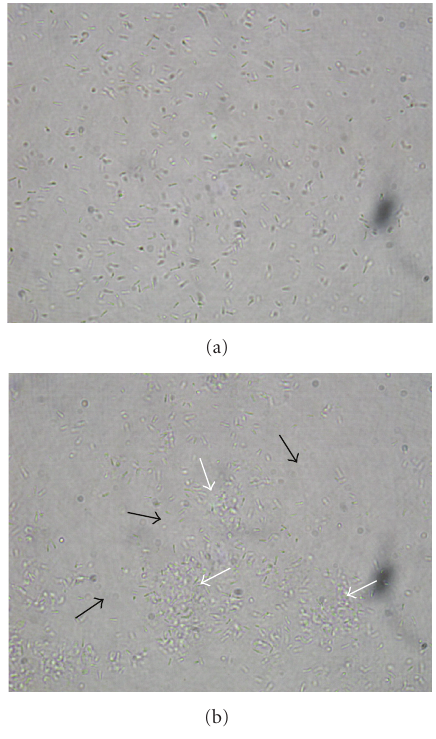
Figure 6: Light microscopy (1000 × magnification) of B. japonicum USDA 110 cells obtained by careful pipetting from wells where biofilms were established by 5 days without (a) or with (b) SBL. In (b), black arrows point to spaces devoid of bacteria, and white arrows point to bacterial aggregates.